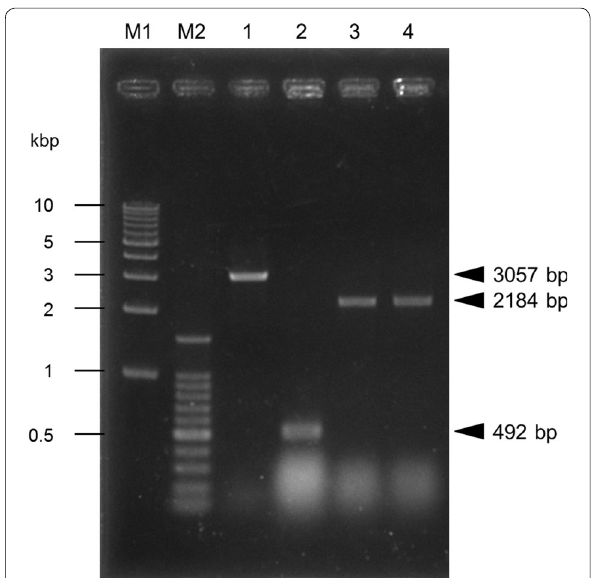
Fig. 2 INU1 deletion and replacement analyzed by agarose gel electrophoresis. Sequences from the transformed cells were PCR‑ amplified and analyzed by agarose gel electrophoresis. A pair of primers (P_Km01‑010 P_Km01‑011) flanking the INU1 locus were + used to amplify intervening sequences. The resulting amplicons from the wild‑type strain (lane 1), inu1 ‑deleted strain Δ inu1 (Km02‑063) (lane 2), or scFv integration strains No. 6 (Km02‑064) (lane 3) and No. 7 (Km02‑065) (lane 4) matched the expected fragment sizes of 3057, 492, 2184, and 2184 bp, respectively. DNA ladder markers (1 Kb and 100 bp) are provided as size standards (lanes M1 and M2, respec‑